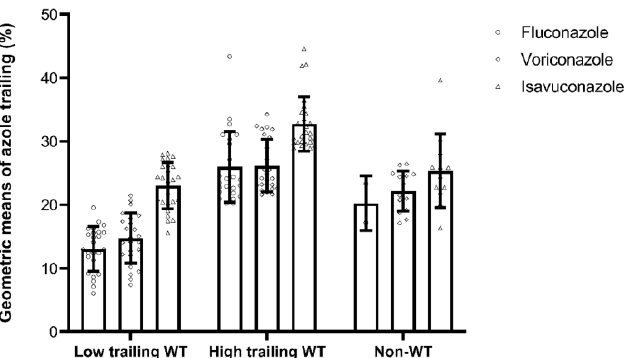
Figure 1. Geometric means of trailing percentages for fluconazole, voriconazole, and isavuconazole among low and high trailing WT and non-WT C. tropicalis isolates. Isolates with fluconazole MICs of Error bars indicate standard